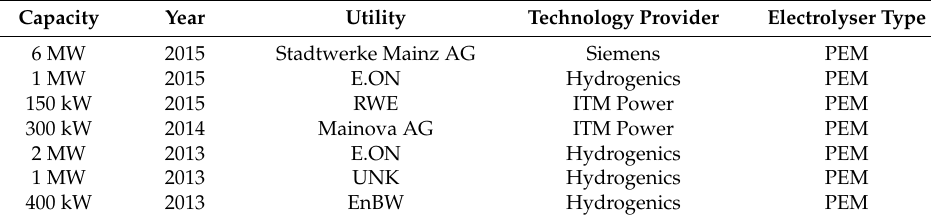
Table 8. Current operational power ‐ to ‐ gas (P2G) projects in Germany [7].